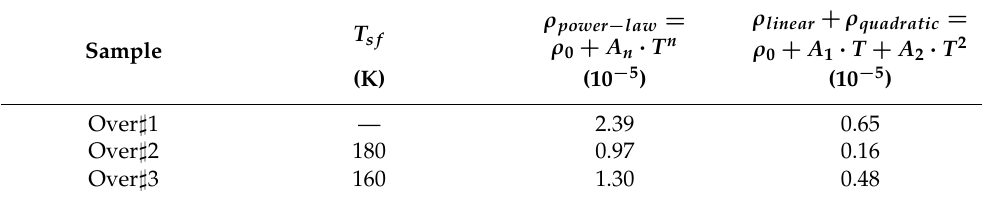
Table 2. Normalized χ 2 values for three selected over-doped SLCO samples. Data refer to samples reported in Figure 3. The low temperature fitting range for Over (cid:93) 2 and Over (cid:93) 3 samples is up to 230K and 210K,